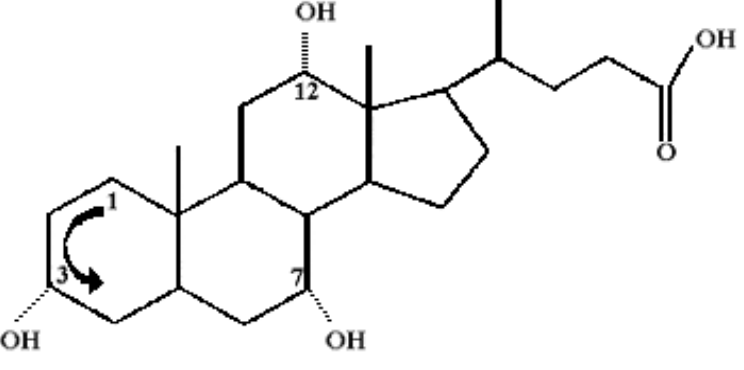
Figure 2. Molecular structure of cholanic acids. OH groups are indicated by dotted lines, methyl ones by full lines. The arrow indicates a counter-clockwise numbering of carbon